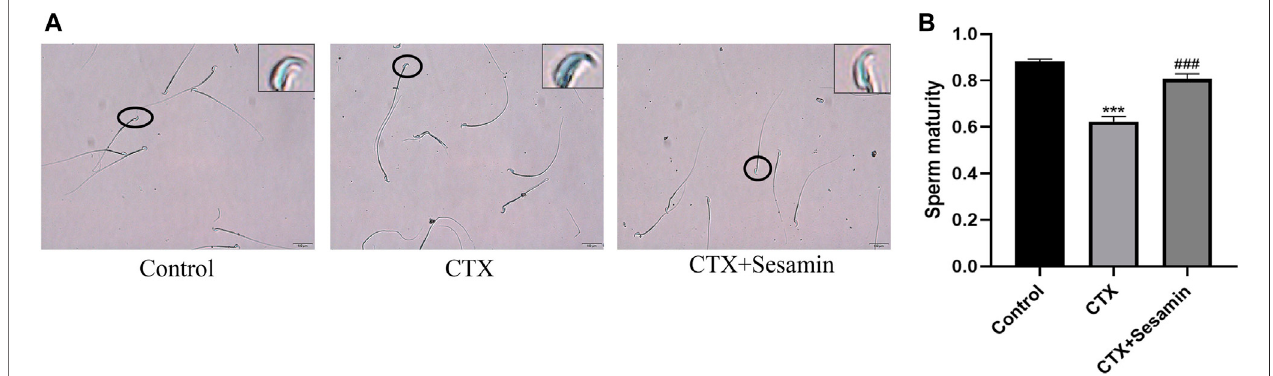
FIGURE7| Typicalresultsoftoluidineblueonspermsmears. (A) Toluidinebluestainingshowsthechromatinstructureofthesperm.Lightblueindicatesthesperm nucleus with a good chromatin structure, and dark blue indicates an abnormal chromatin structure. (B) Sesamin attenuates sperm chromatin condensation induced by CTX exposure in ICR mice. The results are presented as mean ± SEM (n (cid:2) 6). *** p < 0.001 as compared with the control group; ### p < 0.001 as compared with the CTX group.